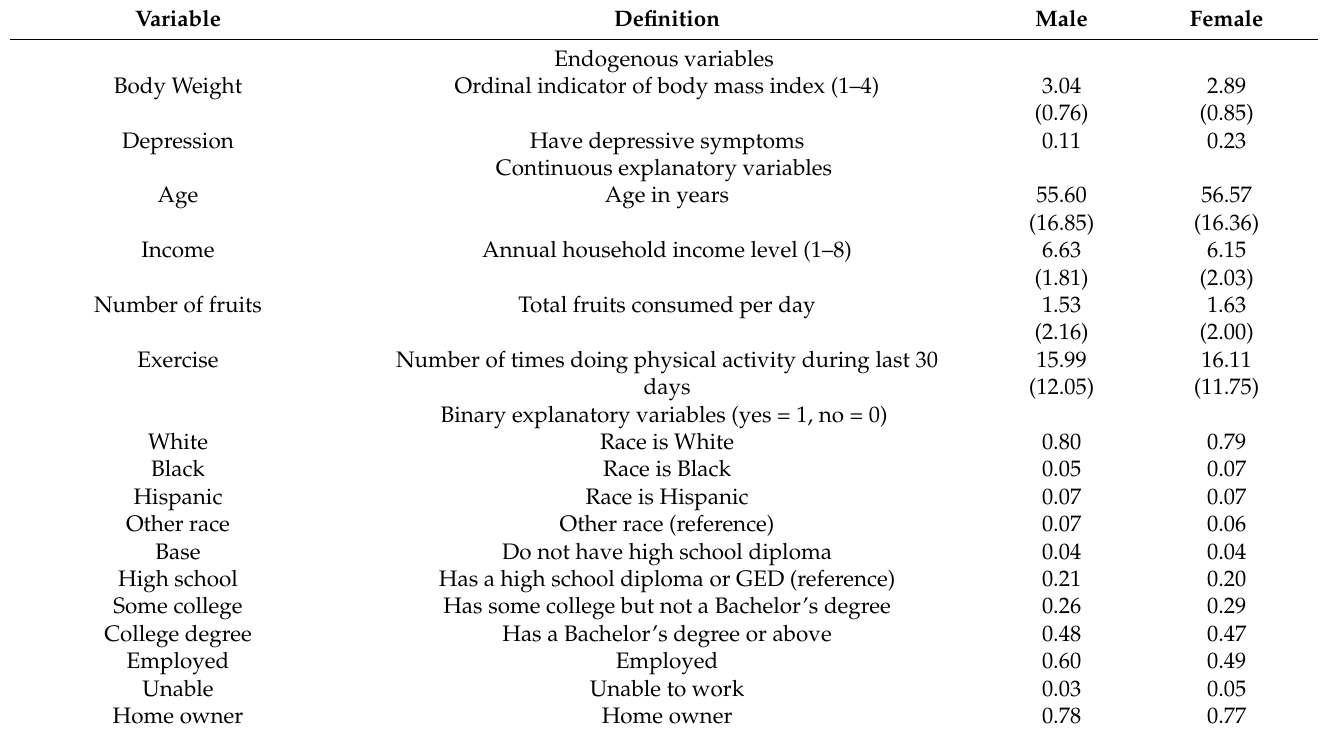
Table A1. Variable definitions and sample